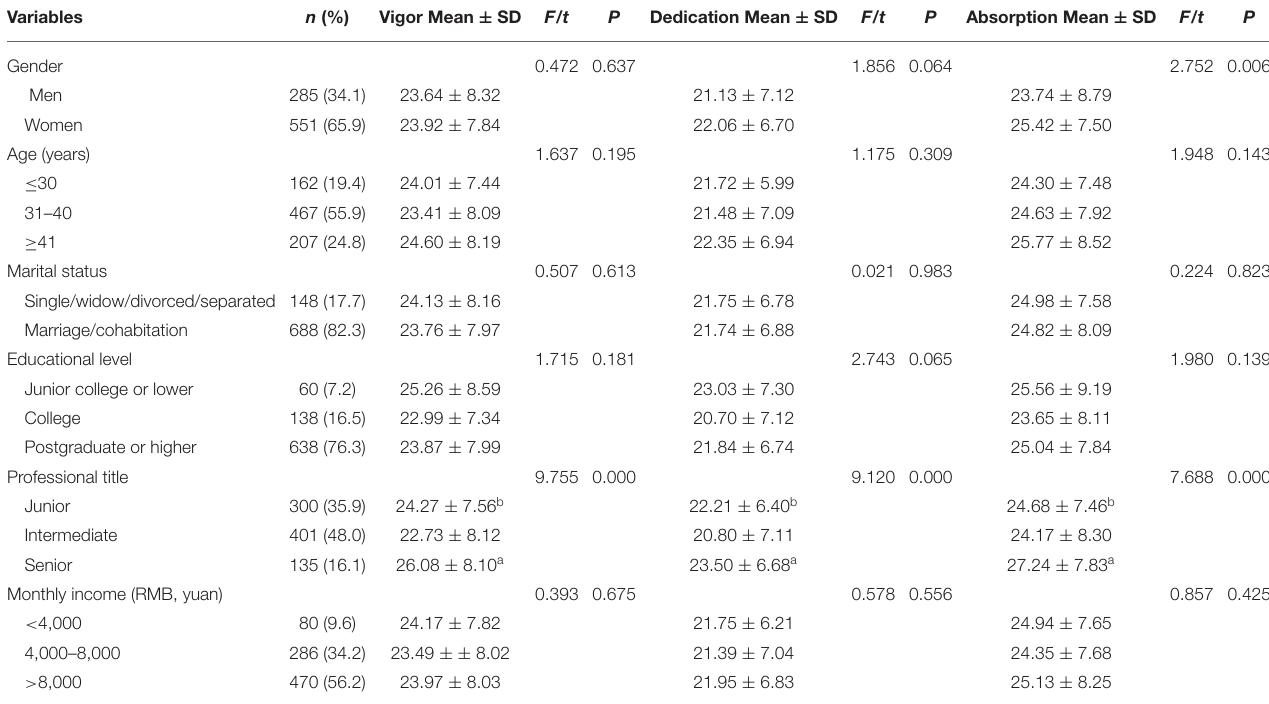
TABLE 1 | Demographic and working characteristics of subjects and comparisons on vigor, dedication, and